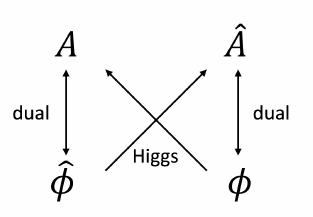
Figure 1: Relations between the four theories in [ 2 ] . The U ( 1 ) tensor gauge theory of A is dual to the non-gauge ˆ φ -theory, while the U ( 1 ) tensor gauge theory of ˆ A is dual to the non-gauge φ -theory. The global symmetry of the φ -theory is the gauge